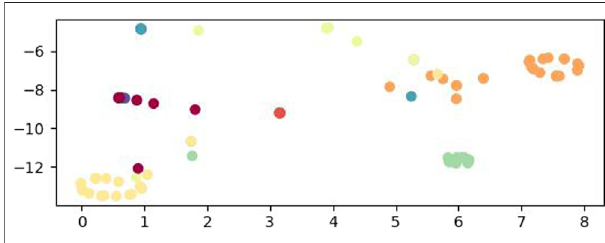
FIGURE 6 | TSNE visualization results.